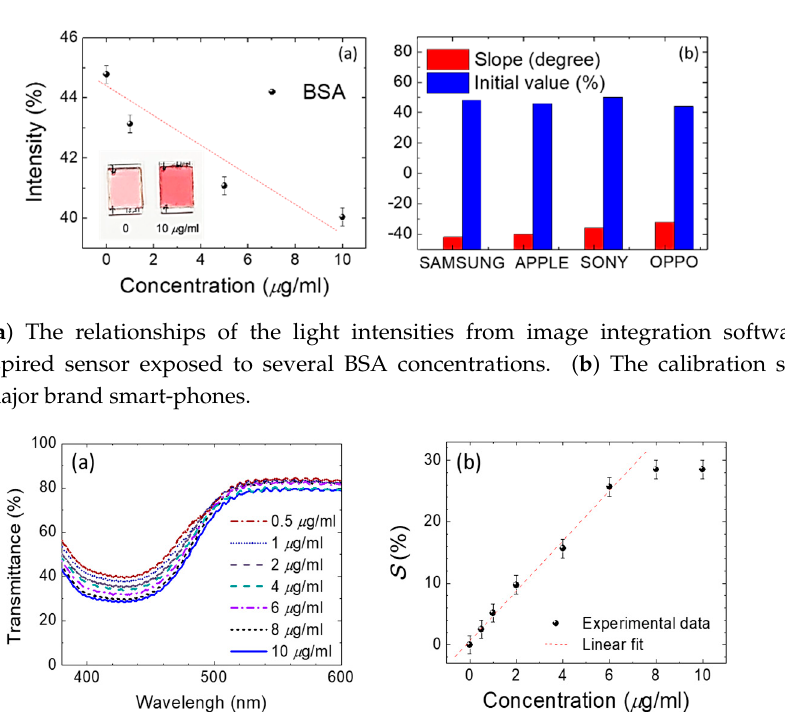
Figure 7. ( a ) Transmission spectra of DDLC cells at bovine serum albumin (BSA) concentrations ranging from 0.5–10 µg/mL. Correlation between the parameter of standard S% (the wavelength transmittance-related loss) and BSA concentrations in DDLC cells. ( b ) Linear relationship with a determination coefficient R2 ≥ 0.93 was found between 0.5 and 10 mg/mL of BSA.